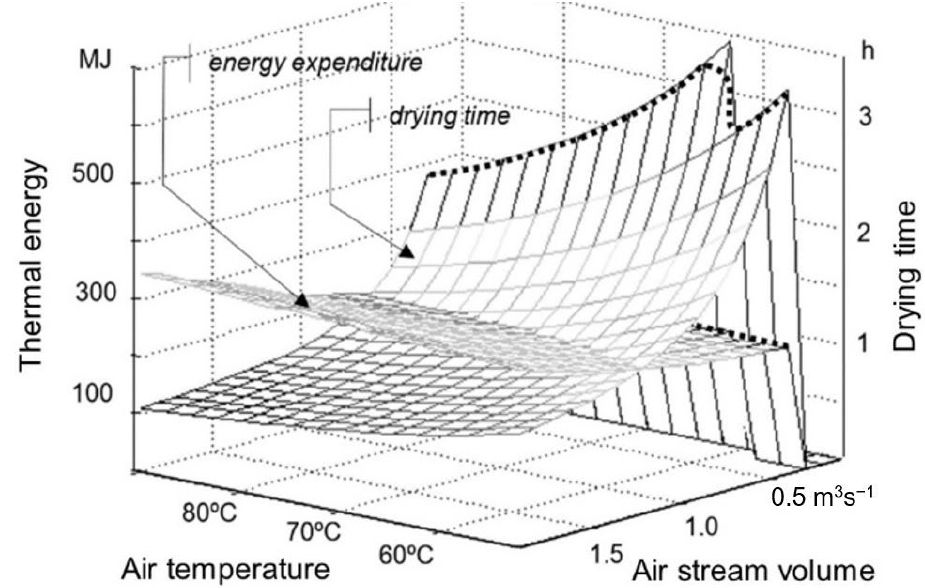
Figure 7. The influence of air temperature and air stream volume on energy consumption and